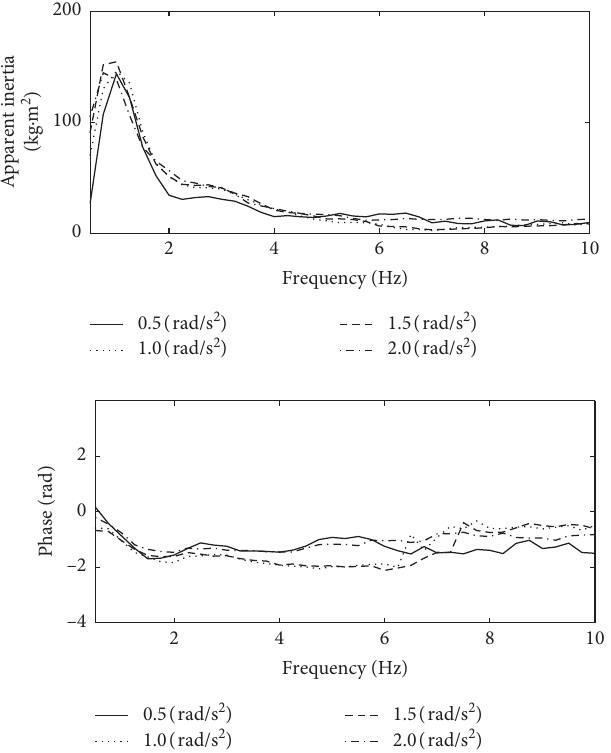
Figure 5: Median apparent inertia of 8 subjects under roll vibration at 4